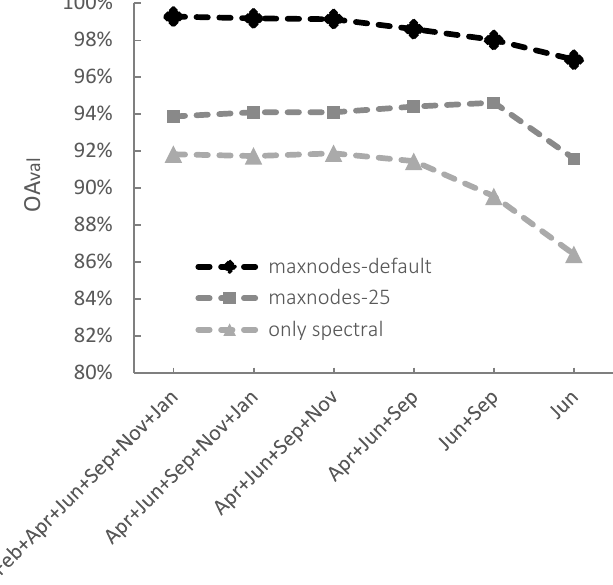
Figure 4. Accuracy of the RF classification by decreasing number of time steps. OA val is the classification accuracy based on validation with an independent data set. For only spectral attributes, maxnodes was